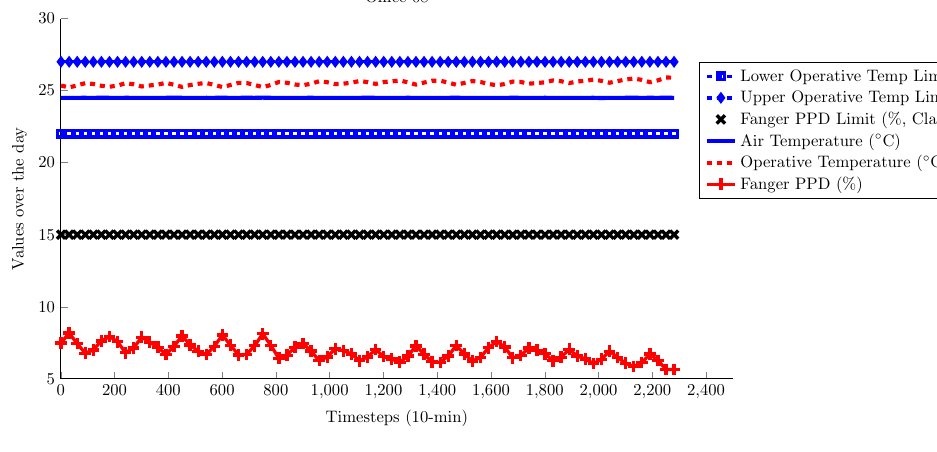
Figure 4. Summer results for Office 08 using the air temperature thermostat set at 24.5 ◦ C.